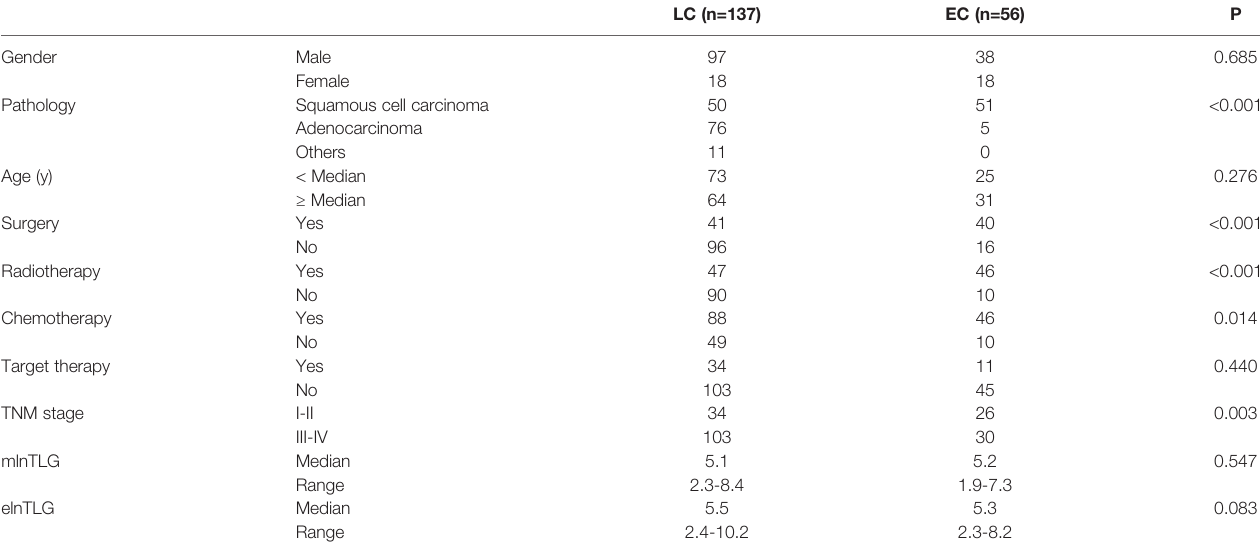
TABLE 2 | Patient